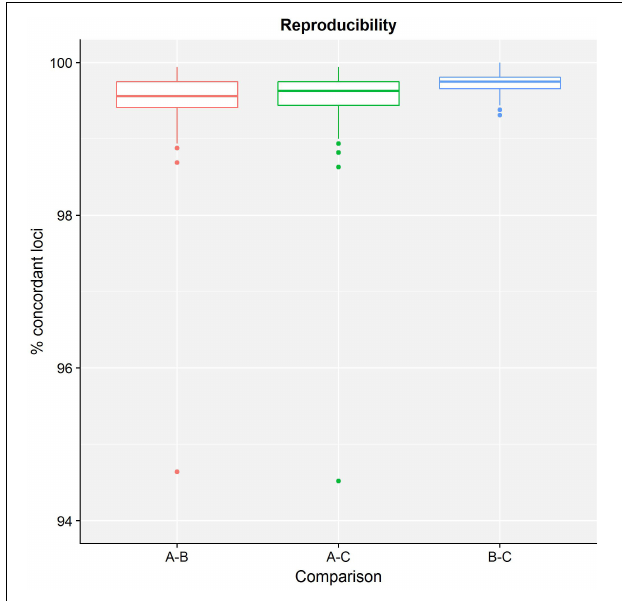
FIGURE 2 | Reproducibility of the sequence typing assay for the core validation dataset. The abscissa depicts the sequencing runs that are being compared, while the ordinate represents the percentage of cgMLST loci that were concordant between the same samples of different sequencing runs. Note that the ordinate starts at 94% instead of 0% to enable illustrating the variation between run comparisons more clearly. Each comparison is presented as a boxplot based on 67 samples where the boundary of the box closest to the abscissa indicates the 25th percentile, the thick line inside the box indicates the median, and the boundary of the box farthest from the abscissa indicates the 75th percentile. See also Supplementary Table S9 for detailed values for all samples and sequencing